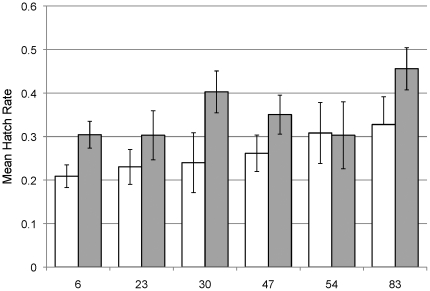
Hatch rates produced by seven-day-old F1 males from reciprocal crosses between Riv84 and the infected Y09 lines.White bars show crosses carrying “old” Wolbachia (Riv84 females mated with males from the line indicated), while grey bars are crosses carrying “new” Wolbachia (females from the lines indicated crossed with males from Riv84).